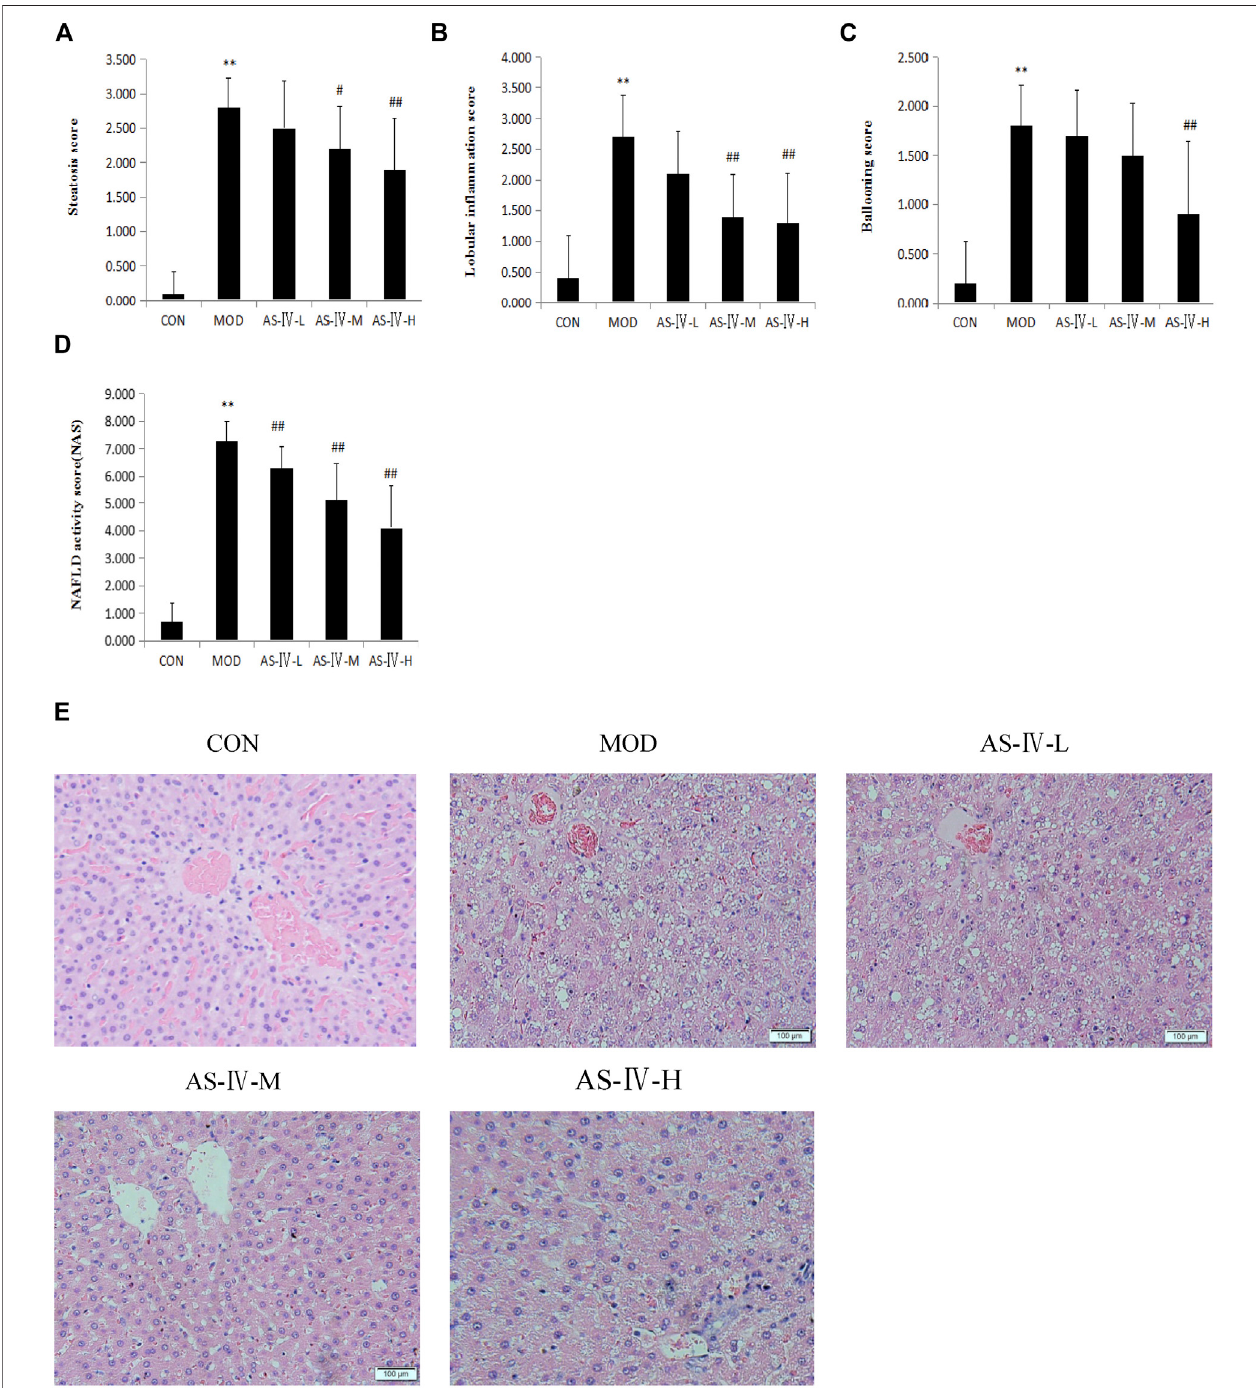
FIGURE 4 | Effects of astragaloside IV on liver histology in HFD-fed rats. (A) Steatosis score of rat liver. (B) Lobular in fl ammation score of rat liver. (C) Ballooning score of rat liver. (D) NAFLD activity score of rat liver. (E) Representative histological change of steatosis in liver sections stained with H&E (magni fi cation 400 × ). Data present the mean ± SD. Comparisons between two groups use t -tests, and data comparison among multiple groups use one-way ANOVA. * p < 0.05 and ** p < 0.01 compared with the control group; # p < 0.05 and ## p < 0.01 compared with the model group. CON, control group; MOD, model group; AS-IV-L, astragaloside IV low-dose group; AS-IV-M, astragaloside IV middle-dose group; AS-IV-H, astragaloside IV high- dose group.